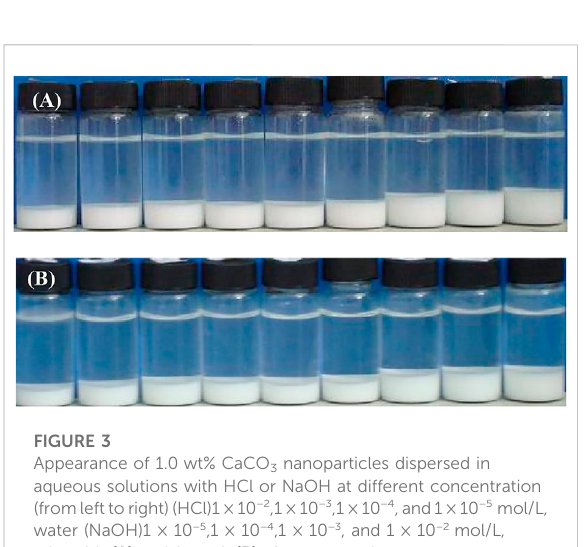
FIGURE 2 Zeta potential of 1.0 wt% CaCO 3 nanoparticles in water of different pH.